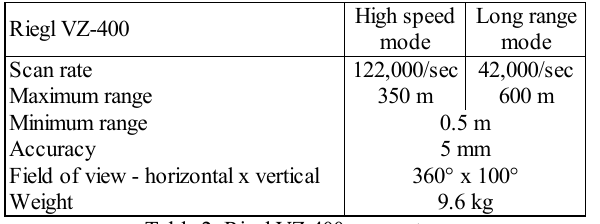
Table 2. Riegl VZ-400 parameters Figure 3. Picture of the church in Čerín